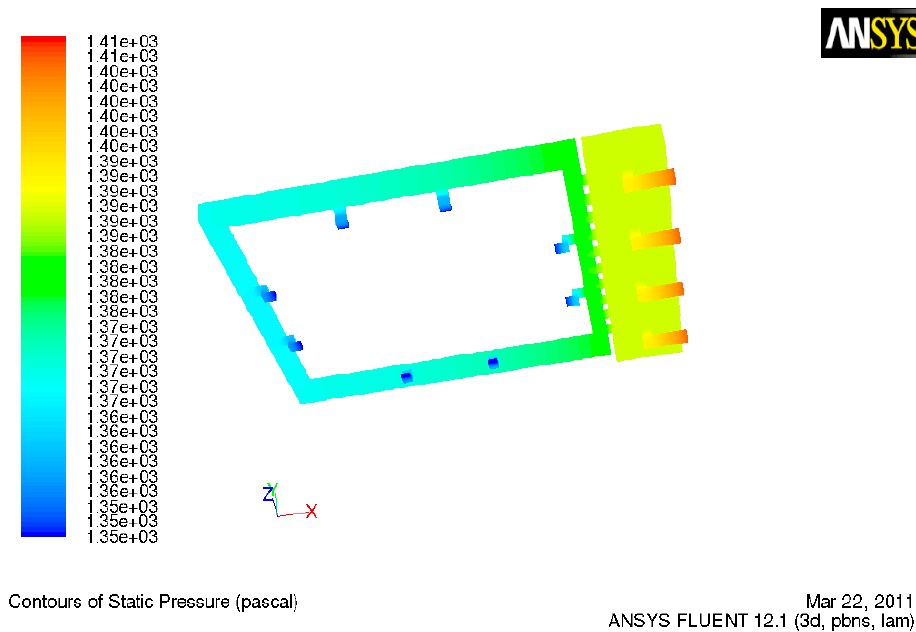
Figure 11. Contours of the pressure suction section.